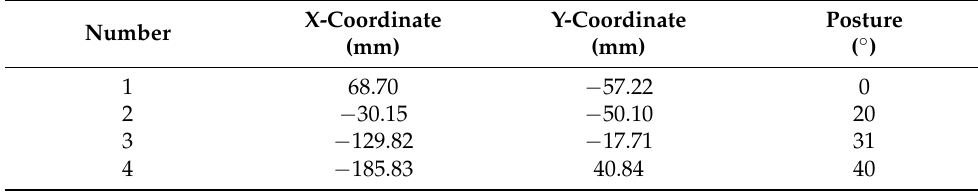
Table 1. The specific values of four task poses.